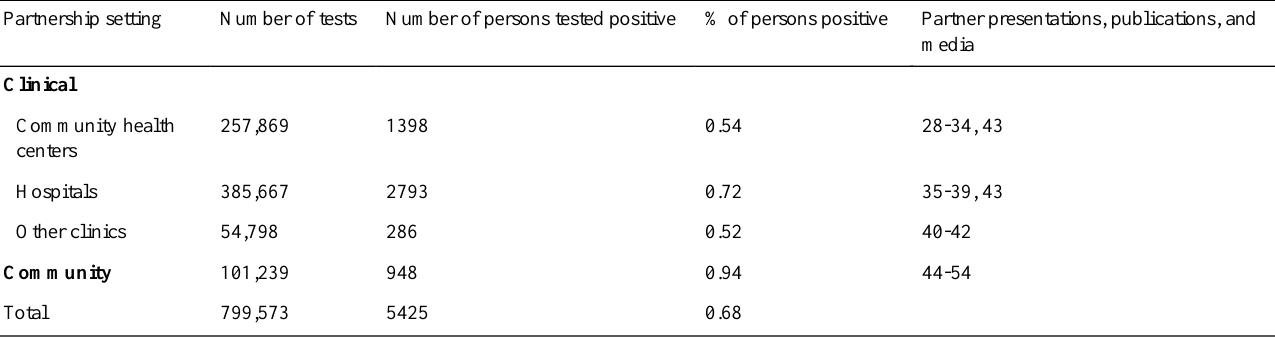
Table 2. FOCUS testing outcomes,